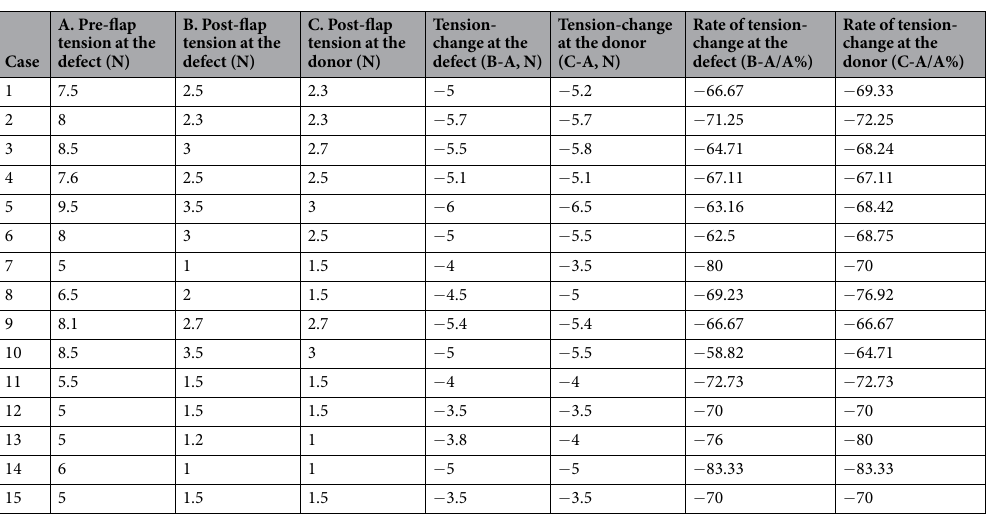
Table 4. Tensiometer data. N,